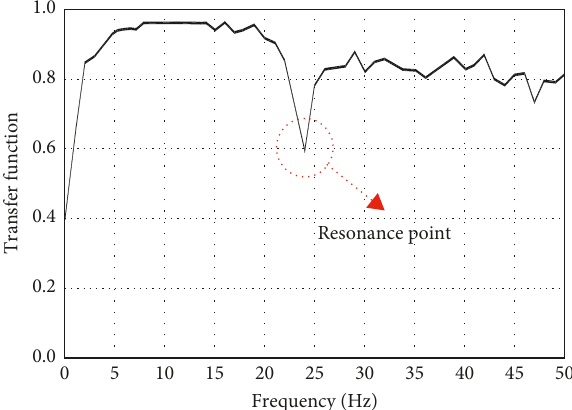
Figure 8: Transfer function of the shake table and